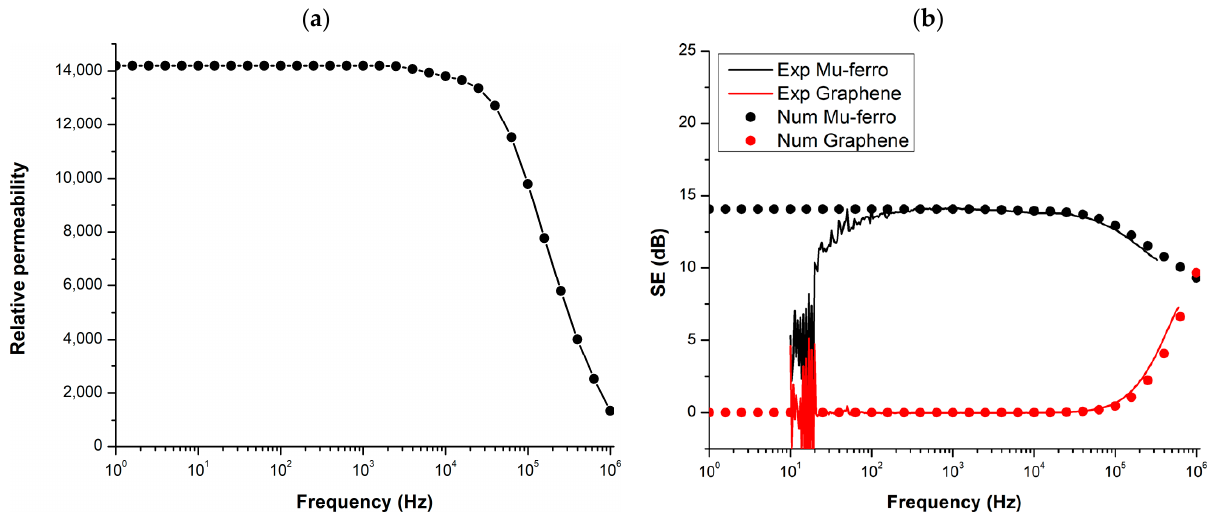
Figure 3. Measured relative permeability of the mu ‐ ferro layer ( a ); experimental (line) and numerical (dot) shielding ef ‐ fectiveness of both mu ‐ ferro and graphene layers for a distance d of 3.05 cm ( b ).